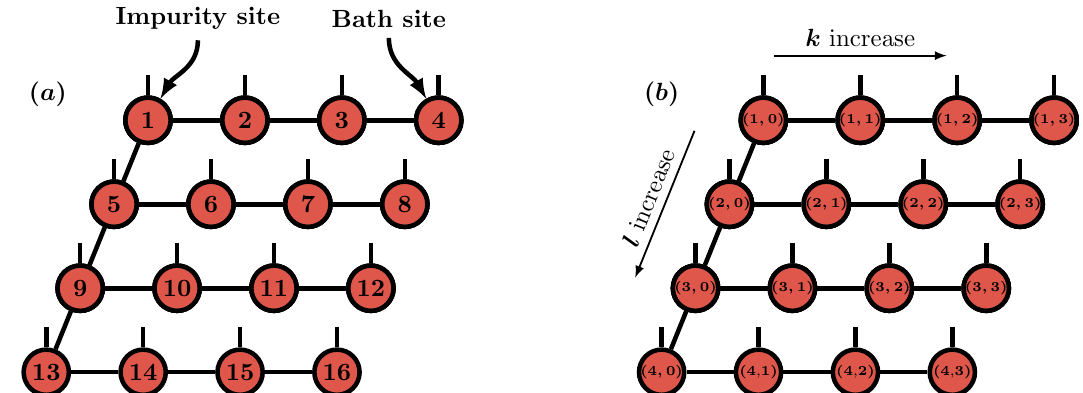
Figure 9: Graphical representation of a FTPS tensor network for a two orbital model. For each orbital, we use two chains, one for each spin-species. (a) one way to label the sites is just to numerate them in ascending order. (b) a different way to label sites is to specify the chain (orbital m and spin σ ) as well as an index (bath index k ). This way to label sites resembles the labels used for the operators of the Hamiltonian in Eq.